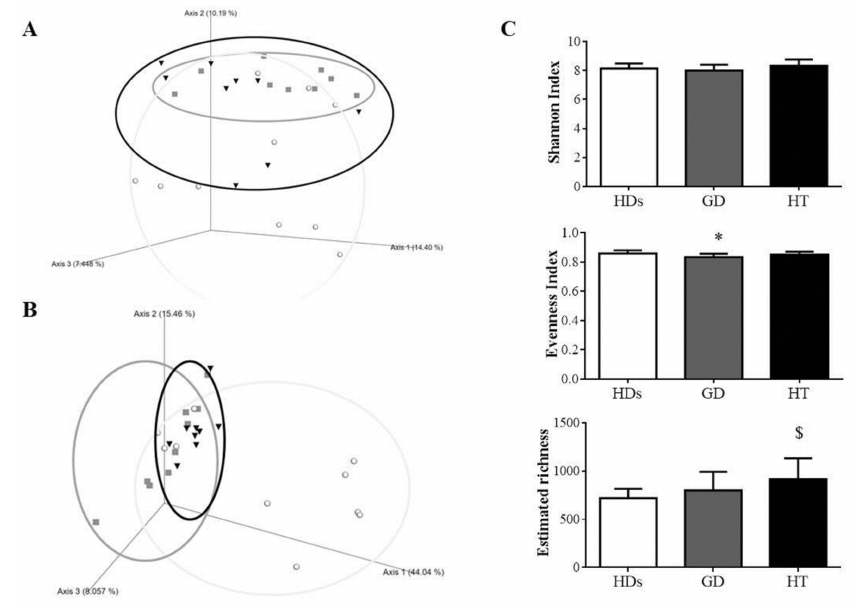
Figure 1. Estimation of diversity in healthy donors (HDs), Graves–Basedow’s disease (GD) patients, and Hashimoto’s thyroiditis (HT) patients. Clustering of fecal bacterial communities according to the di ff erent study groups by PCoA using unweighted and weighted UniFrac distances. Statistical di ff erences were observed between groups. ( A ) Unweighted UniFrac distances, p = 0.003; and ( B ) Weighted UniFrac distances, p = 0.002. Dots belong to the HDs group; square to GD patients and cone to HT patients. ( C ) Shannon Diversity and Evenness indexes and estimated richness among di ff erent groups were compared. All values are mean ± SD. * p < 0.05 GD patients vs. HDs; $ p < 0.05 HT patients vs. HDs. Circles belong to the HDs; squares to GD patients and triangles to HT